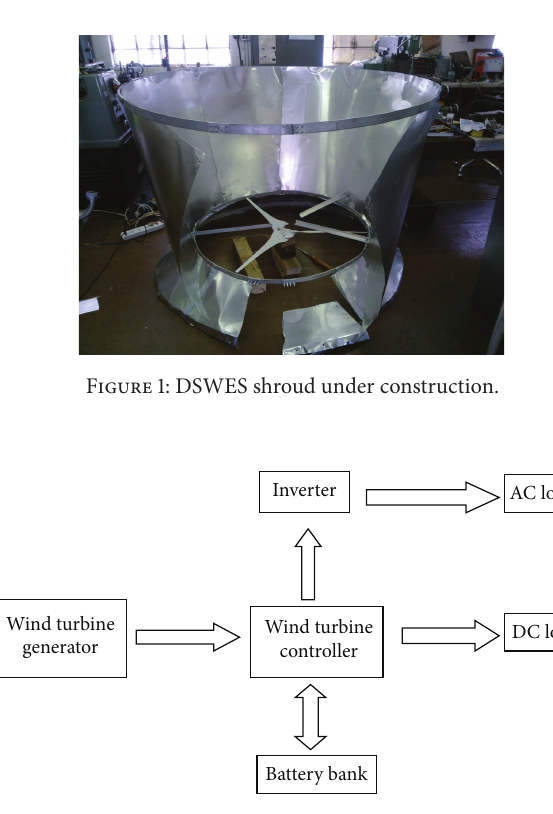
Figure 2: Schematic diagram of typical DSWES/SWES.